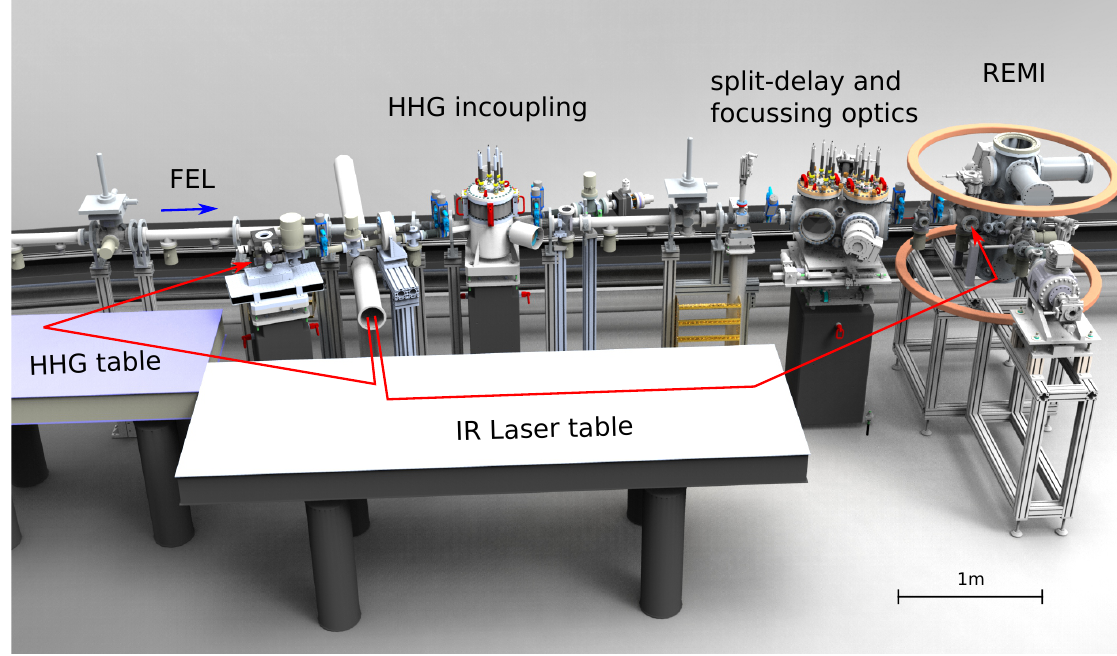
Figure 1. Overview of the reaction microscope (REMI) endstation. The free-electron laser (FEL) is delivered from the left, while the infrared (IR) laser is delivered from the rear, crossing below the beamline. The IR is coupled into the beamline right before the REMI with a holey mirror. The HHG (high harmonic-generation) light is coupled by a grazing angle about 3m upstream (indicated by the two red